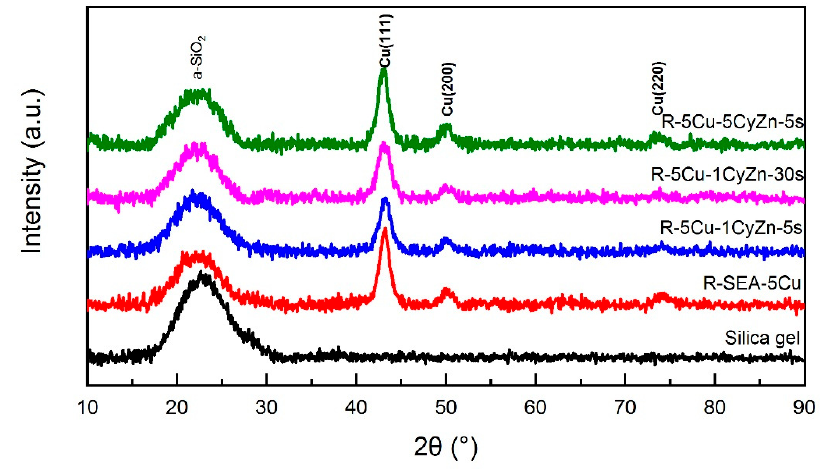
Figure 3. XRD patterns corresponding to SiO 2 , SEA-5Cu, and ZnO over-coated Cu/SiO 2 catalysts.